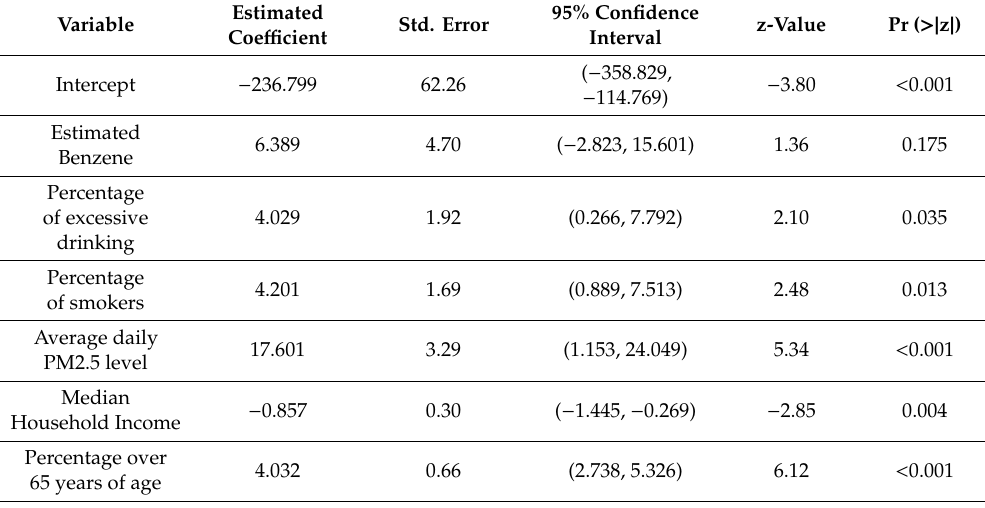
Table 1. Results from Conditional Autoregressive Linear